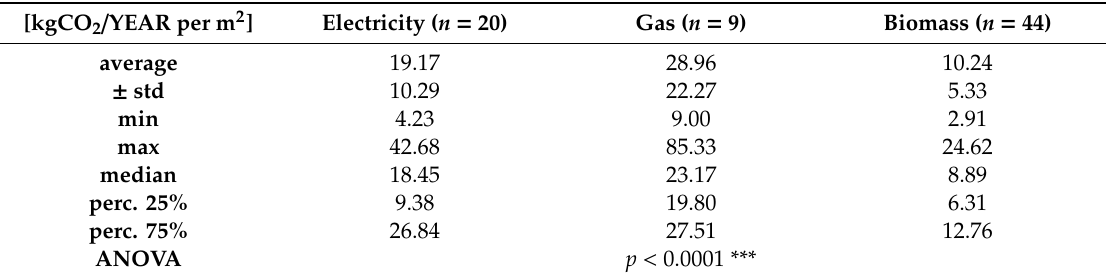
Table 11. Annual CO 2 production in relation to heating categorized according to heating medium type calculated per m 2 of useful floor area of the analyzed wood constructions regardless of the construction